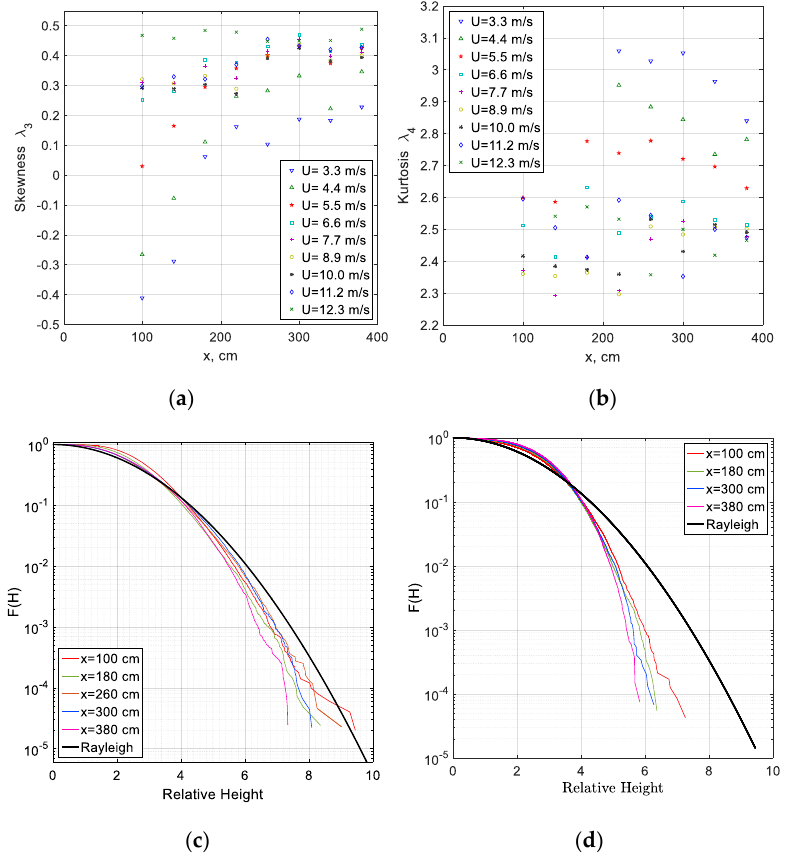
Figure 9. Deviation of random wind waves from Gaussianity. ( a ) The skewness coefficient; ( b ) the kurtosis coefficient; ( c ) wave height exceedance F ( H ) for U max = 3.3 m/s for selected fetches; ( d ) as in ( c ) for U max = 12.3 m/s.